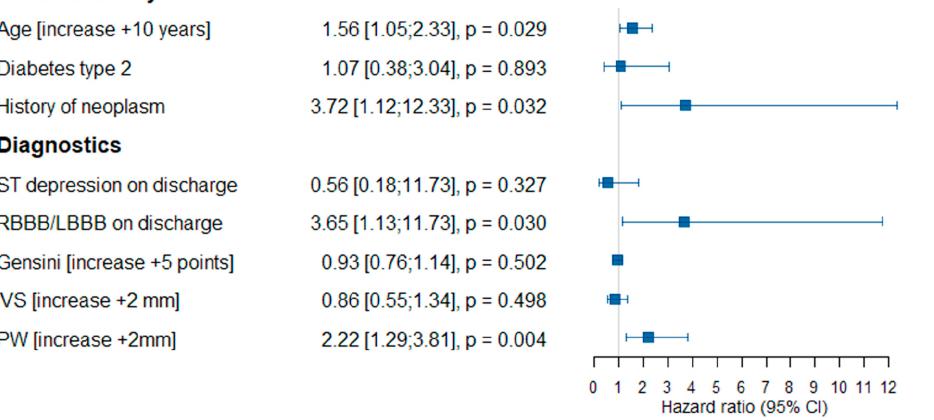
Figure 4. The multivariate Cox proportional hazards model for primary composite endpoint occurrence. Abbreviations: HR—hazard ratio, RBBB—right bundle branch block, LBBB—left bundle branch block, IVS—intraventricular septum thickness, PW—posterior wall